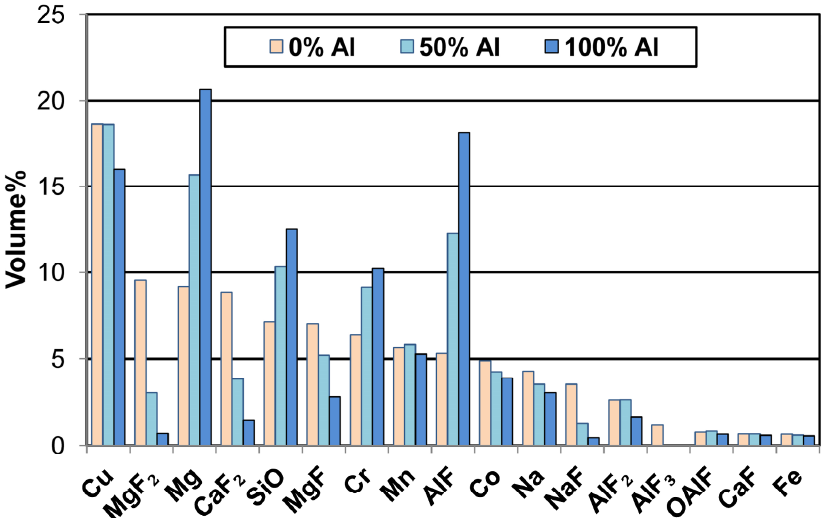
Figure 10. MP11 weld gas composition (volume%) output from gas–slag–metal powder equilibrium at 2500 °C, calculated in FactSage 7.3 thermochemical software (Equilib module) [35]. Table 6. MP11 expected metal loss to gas according to gas–slag–metal powder equilibrium at 2500 °C, calculated in FactSage 7.3 thermochemical software (Equilib module) [35].